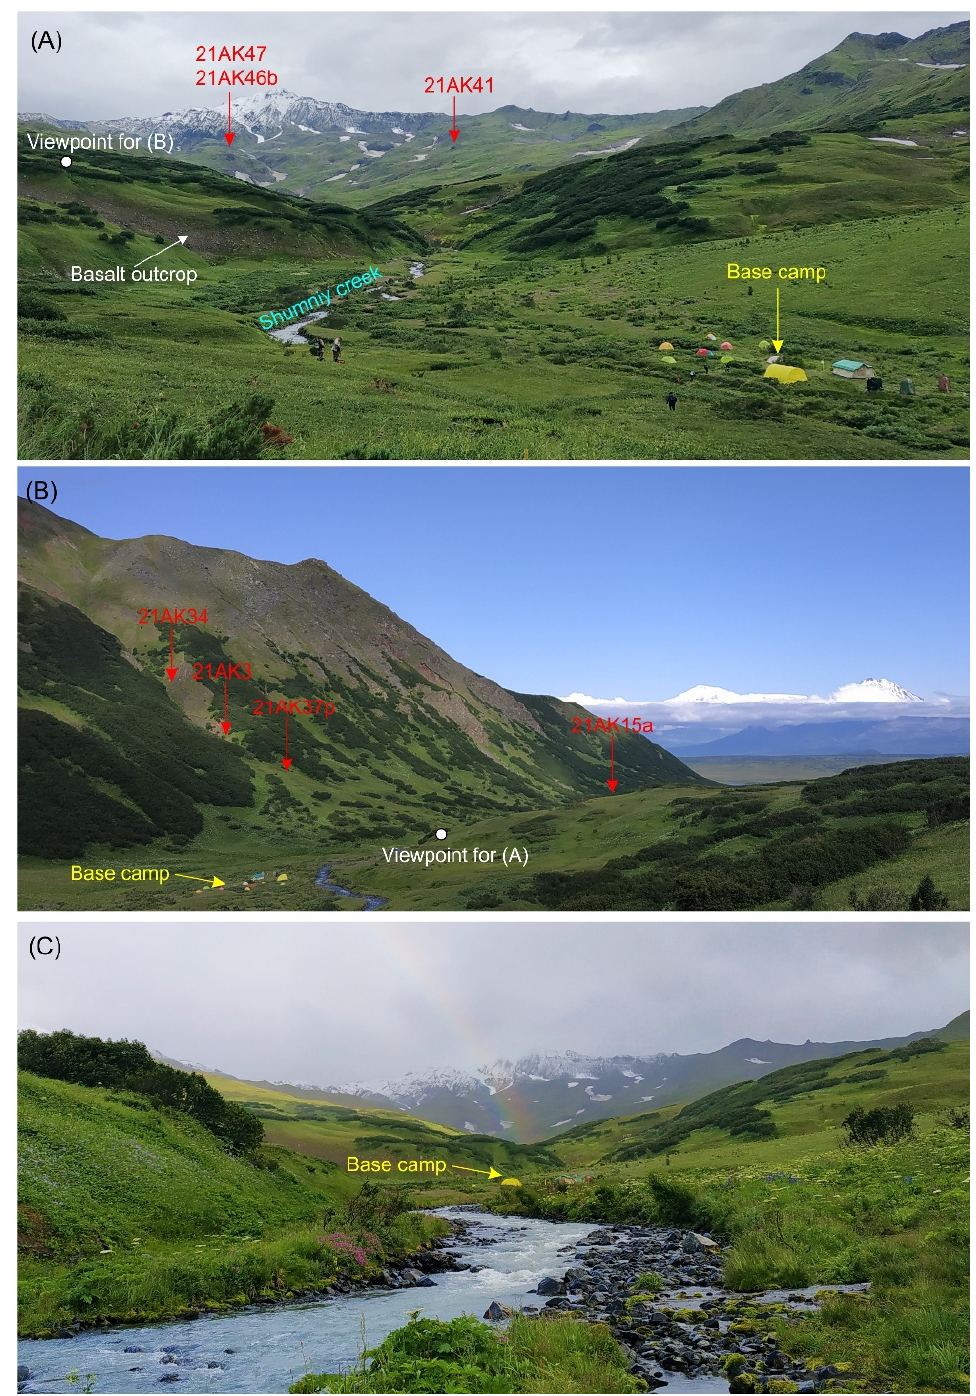
Figure 2. Photographs of the studied occurrence. ( A ) Southeastern view; ( B ) Northwestern view; ( C ) stream of the Shumny creek with boulders in the alluvium. Sampling locations are labeled red.